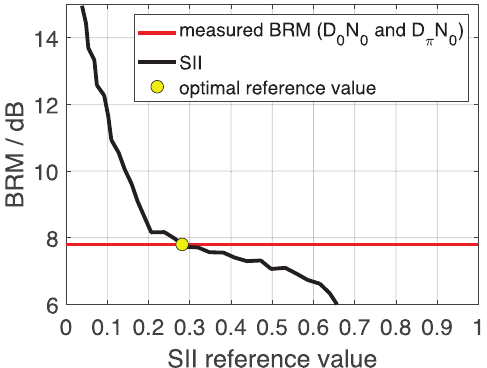
Figure 1. Predicted binaural release from masking (BRM, shown on the y -axis) de fi ned as the difference between SRTs of the fi rst condition of experiment I ( D 0 N 0 ) and the fi rst condition of experiment III ( D p N 0 ) using bBSIM-SII. The SII reference values are shown on the x -axis. The red line shows the measured BRM of 7.8 dB. The yellow circle shows the optimal reference SII of 0.28, which allows accurate prediction of the measured BRM and was selected for the following predictions.